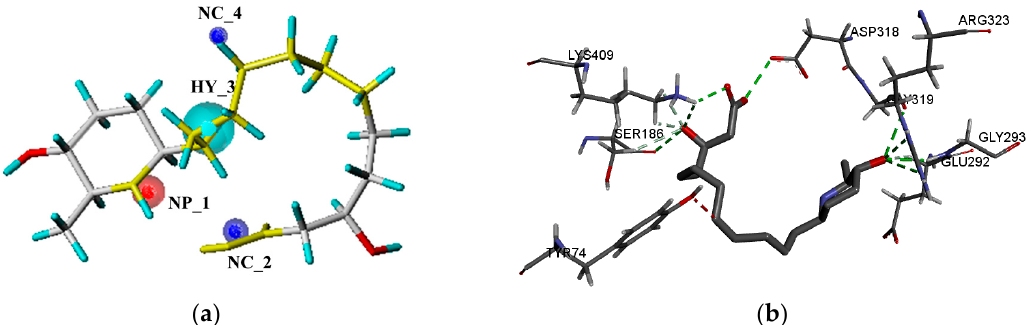
Figure 5. ( a ) The mapping results of Morusimic acid D with the best pharmacophore of orhtosteric site of mGluR I; ( b ) the docking result of Morusimic acid D with the crystal mGluR1.